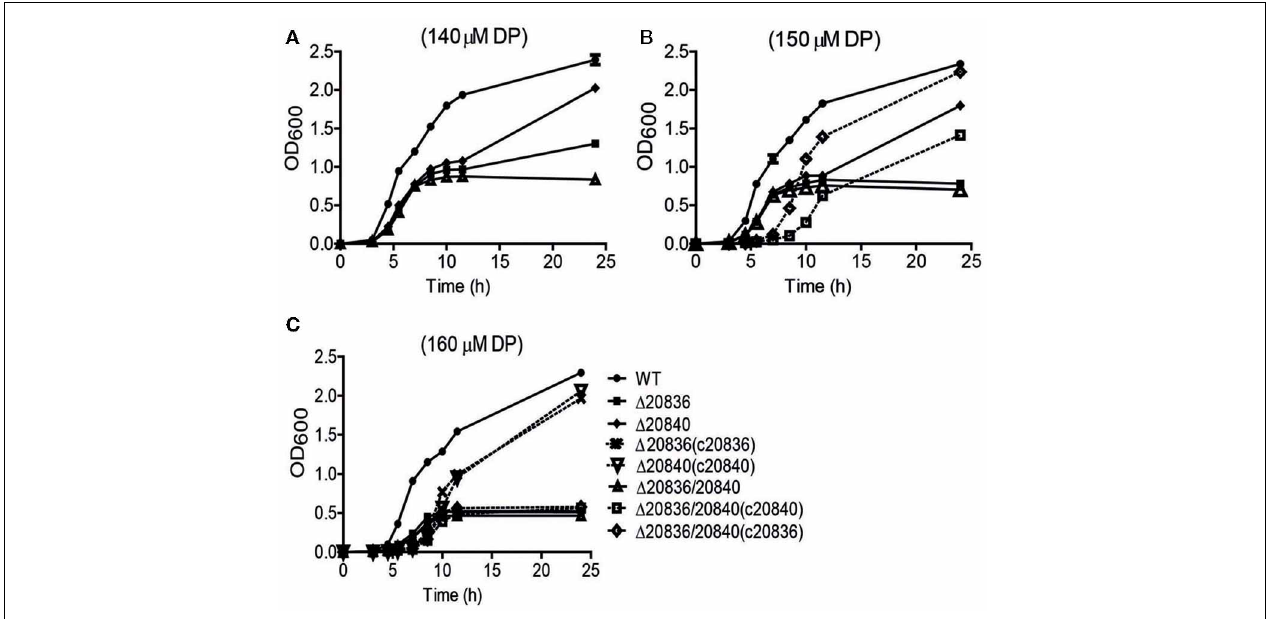
FIGURE 4 | Growth characteristics of wild-type V. vulnificus CMCP6 and various AMP ligase gene mutants under iron-limited conditions. WT, (cid:2) 20836, (cid:2) 20840, (cid:2) 20836/20840, and complemented strains were grown in 2.5% NaCl-HI broth with